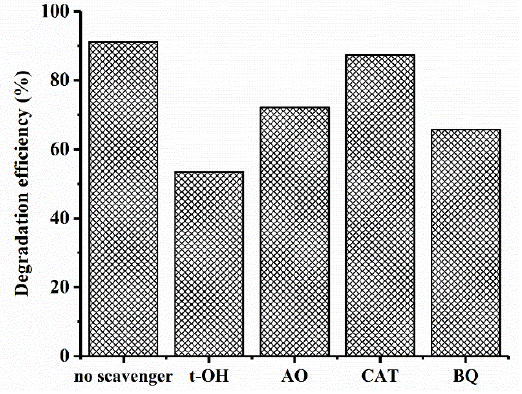
Figure 10. Effect of scavengers on the photocatalytic activity of CuO – Cu 2 O.